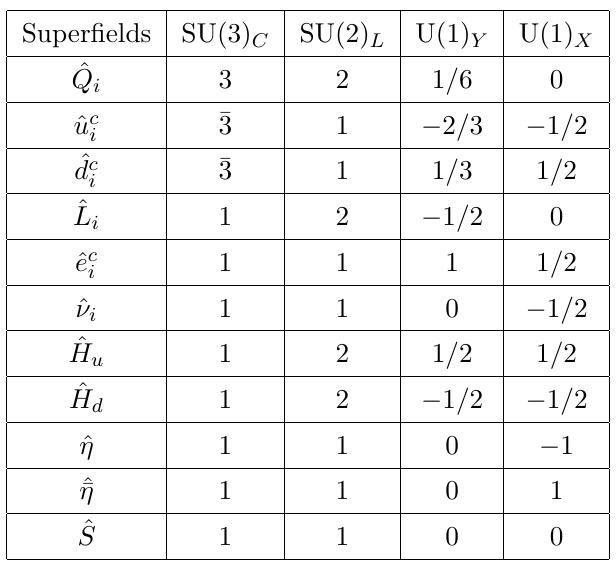
Table 1 . The super(cid:12)elds in U(1) X